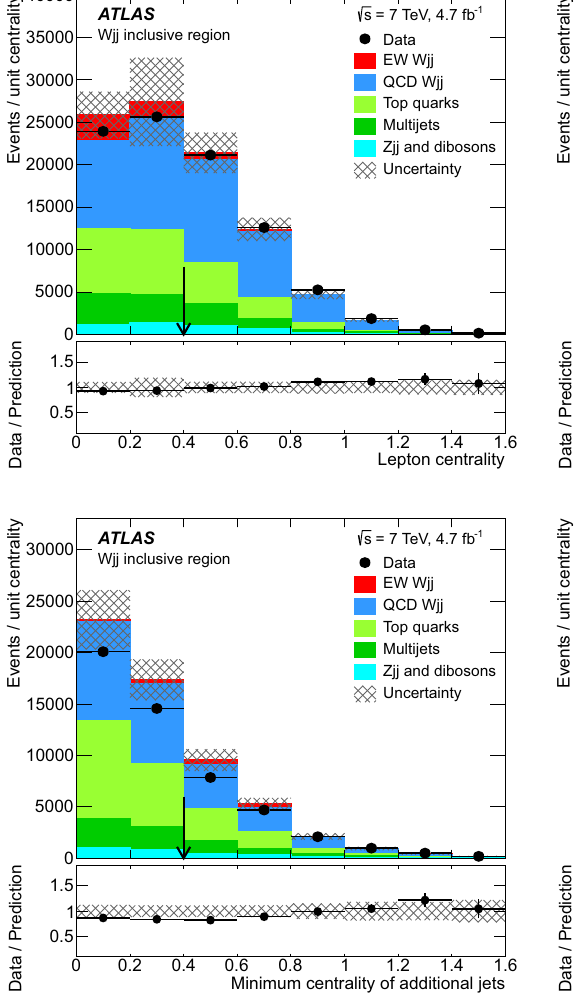
selection(tothe right ).The arrows inthejet-centralitydistributionssep- aratethesignal-regionselection(tothe right )fromthevalidation-region selection (to the left ). The bottom panel in each distribution shows the ratio of data to the prediction. The shaded band represents the statistical and experimental uncertainties summed in